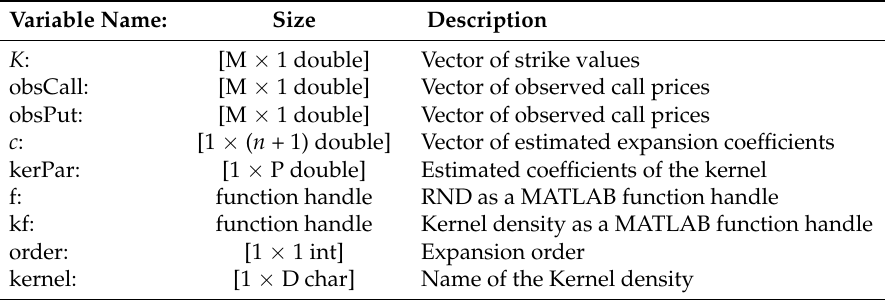
Table 2. Output format.